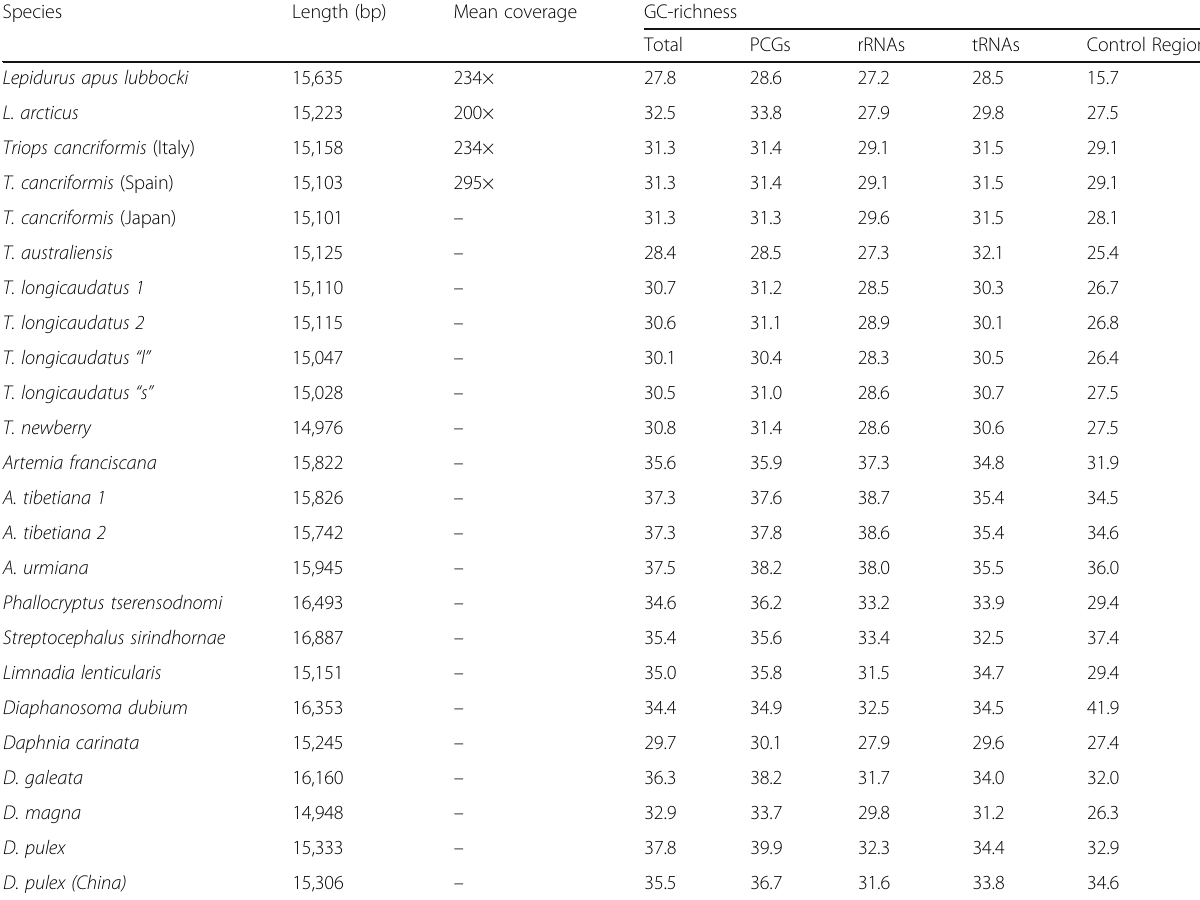
Table 2 General information and nucleotide features of newly sequenced mitogenomes and of those drawn from Genbank